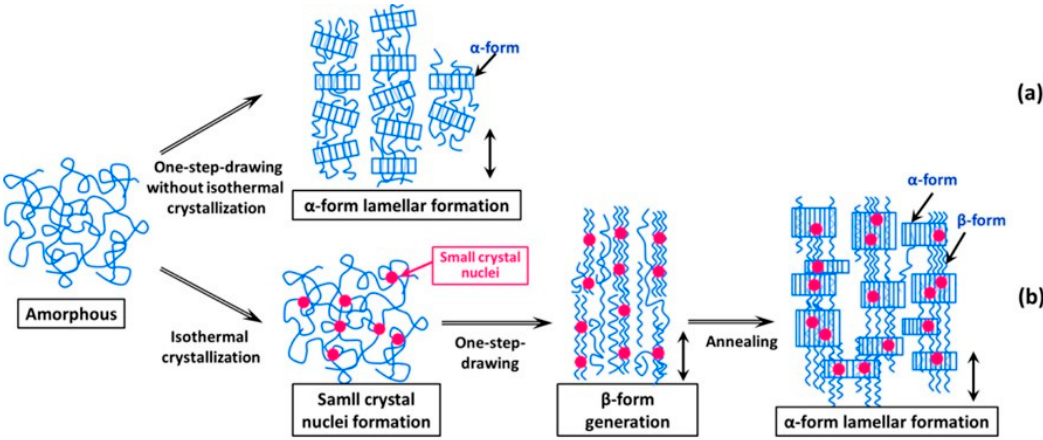
Figure 9. Mechanism for generating the planar zigzag conformation ( β -form) in high-strength PHBHV fibers by different drawing methods: ( a ) one-step-drawing without isothermal crystallization; ( b ) one-step-drawing after isothermal crystallization. Reprinted with permission from [121]. Copyright 2006 American Chemical Society.